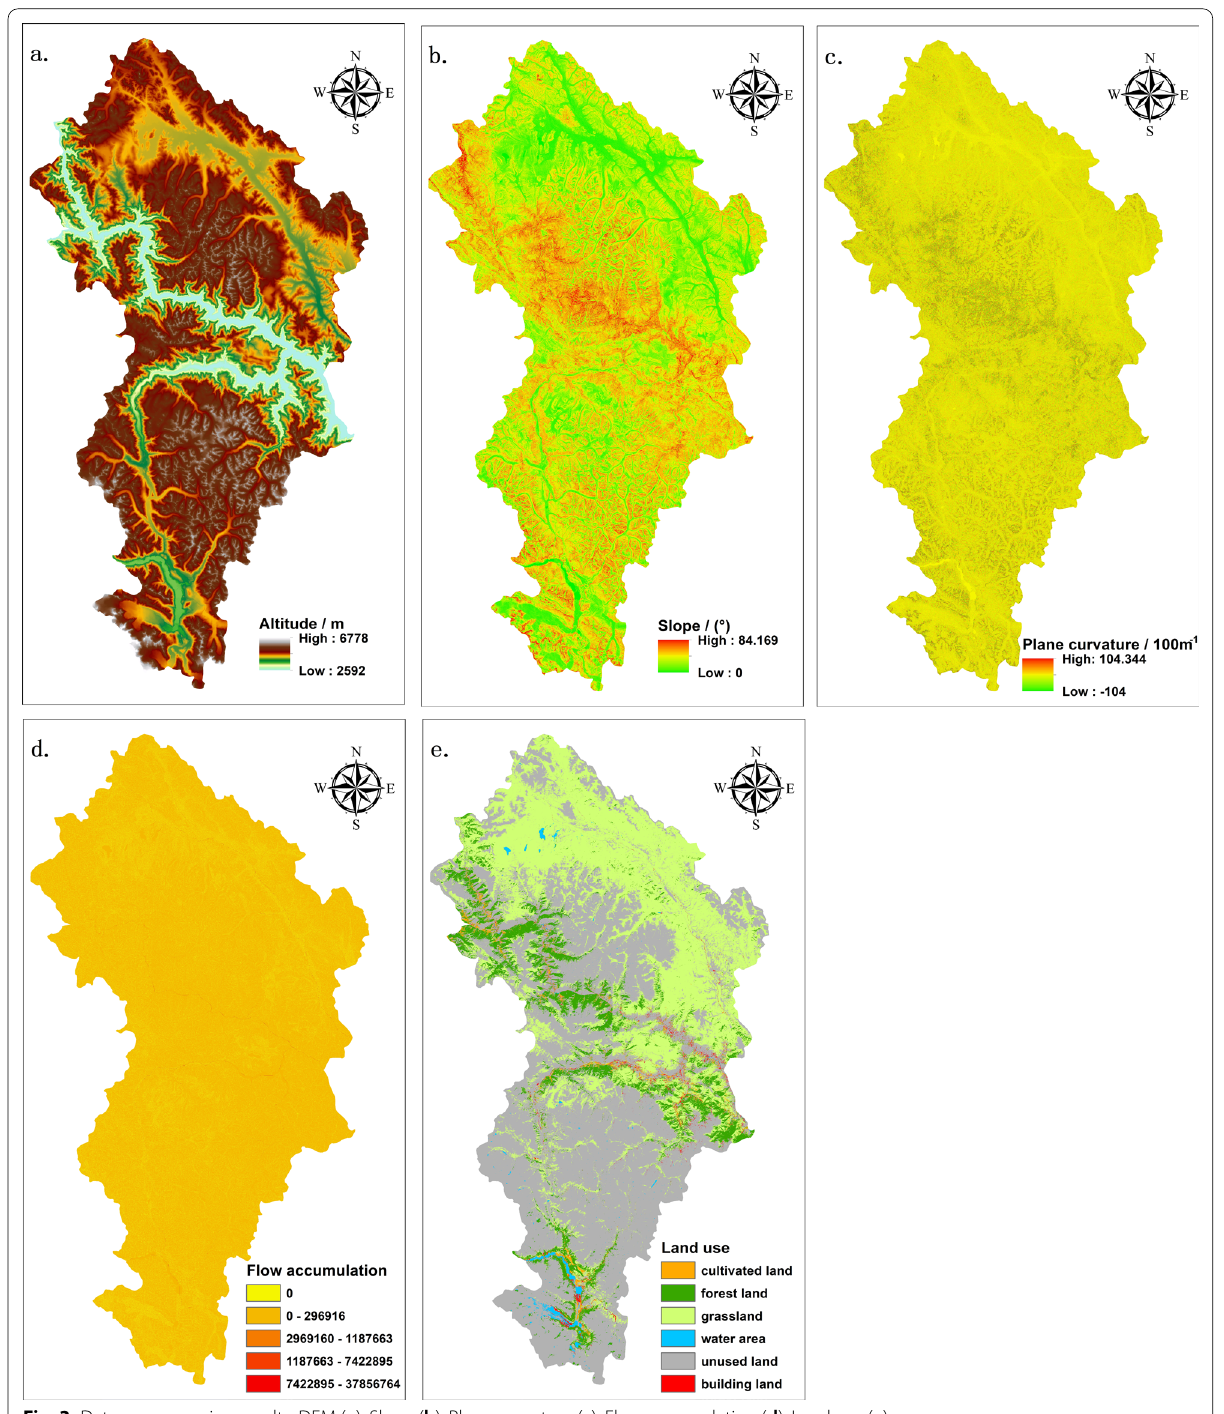
Fig. 3 Data preprocessing results. DEM ( a ); Slope ( b ); Plane curvature ( c ); Flow accumulation ( d ); Land use ( e